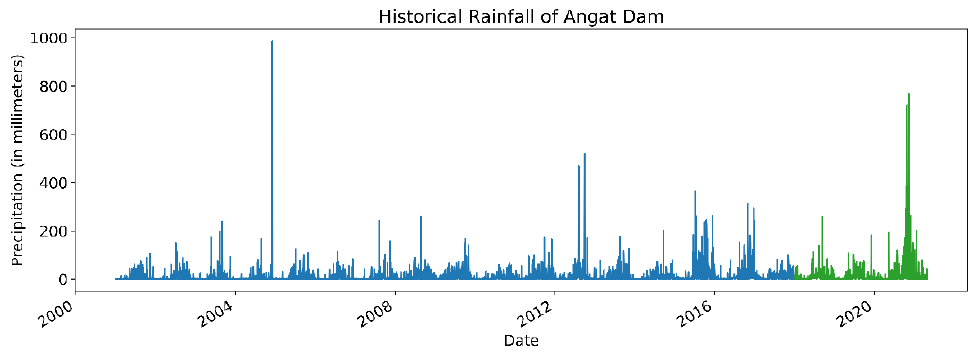
Figure 2. Historical water levels (above mean sea level) of the Angat Dam, from 1 January 2001 to 30 April 2021, in meters. The time series shows a drastic drop in 2019 (corresponding to the 2019 Metro Manila Water Crisis) that has only been seen on one other occasion, in 2010. Blue observations denote the training set and green observations denote the test set.